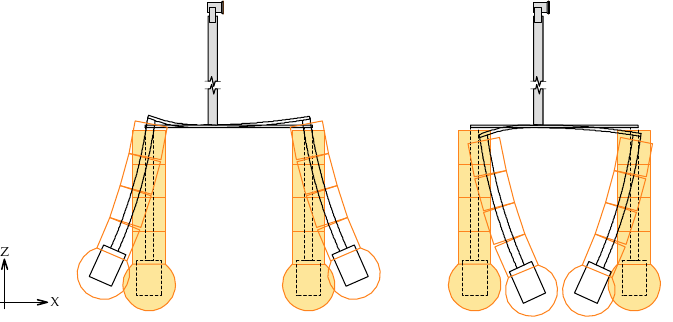
Figure 10. Schematic of the elastic response mode before the 2.0 s wave period [18].